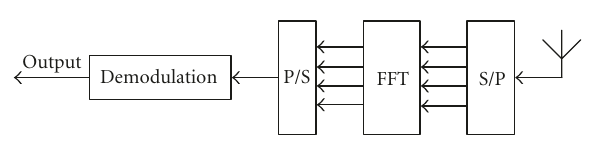
Figure 1: Mobile terminal